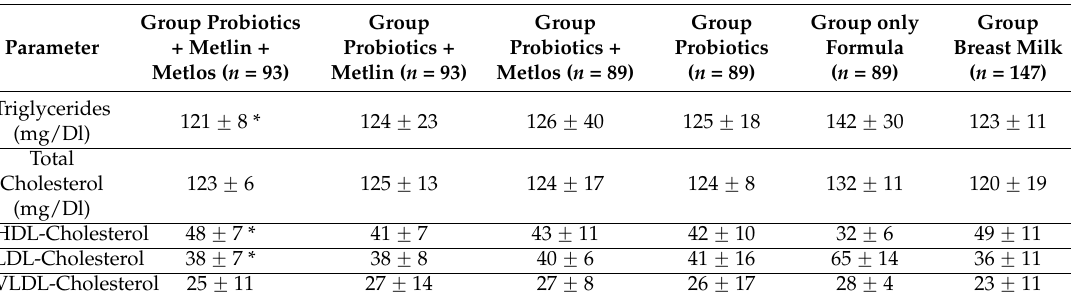
Table 4. Levels of triglycerides and